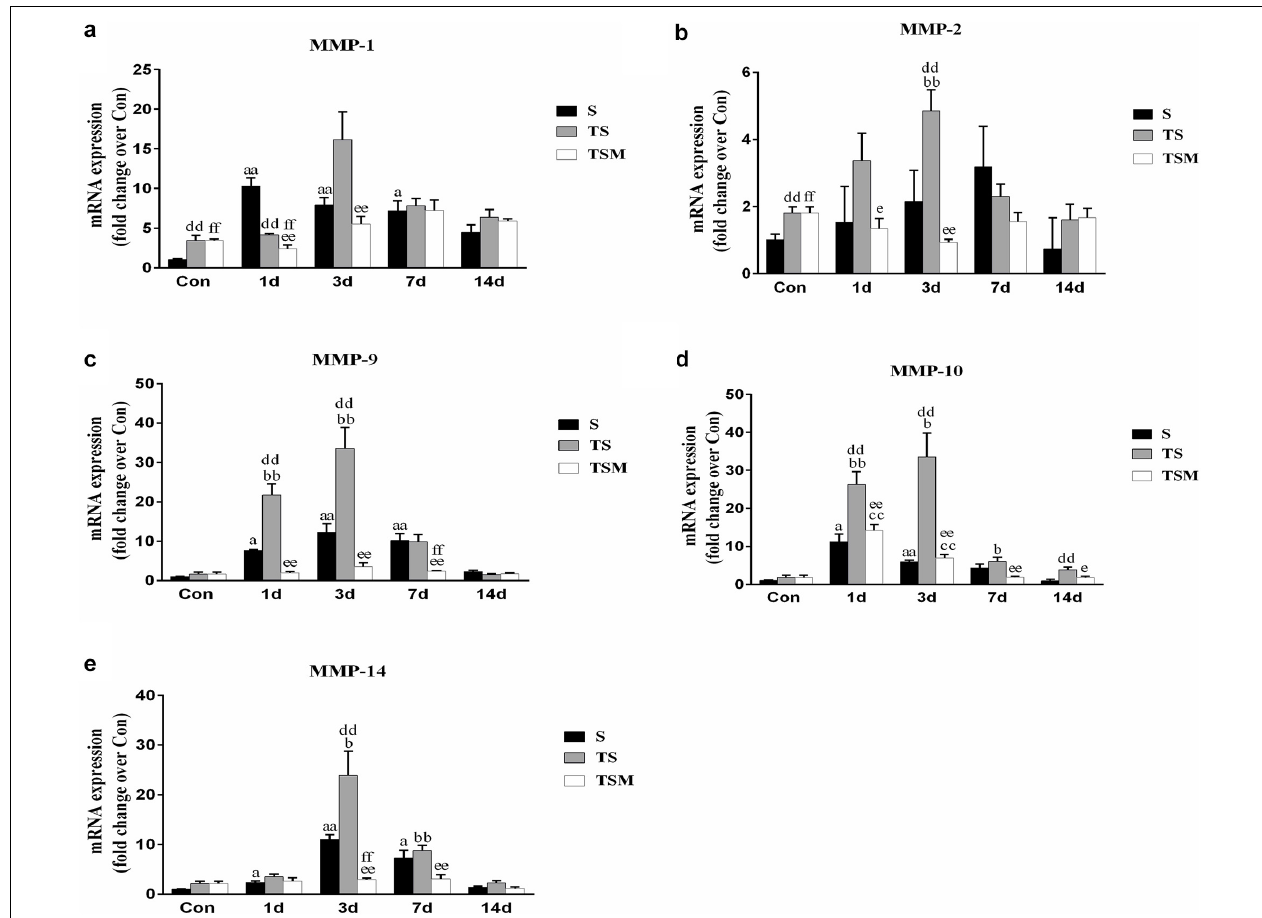
FIGURE 11 | Effects of MGF treatment on the expression of MMP. (a) The expression of MMP-1; (b) The expression of MMP-2; (c) The expression of MMP-9; (d) The expression of MMP-10; (e) The expression of MMP-14. S, muscle contusion group; TS, muscle contusion and macrophage depleted group; TSM, muscle contusion, macrophage depletion and MGF treated group. Data are means ± SEM, n = 8; a Significant difference from Scon, p < 0.05; aa p < 0.01. b Significant difference from TScon, p < 0.05; bb p < 0.01. c Significant difference from TSMcon, p < 0.05; cc p < 0.01; d Significant difference between group TS and group S, p < 0.05; dd p < 0.01; e Significant difference between group TS and group TSM, p < 0.05; ee p < 0.01; f Significant difference between group TSM and group S, p < 0.05; ff p <